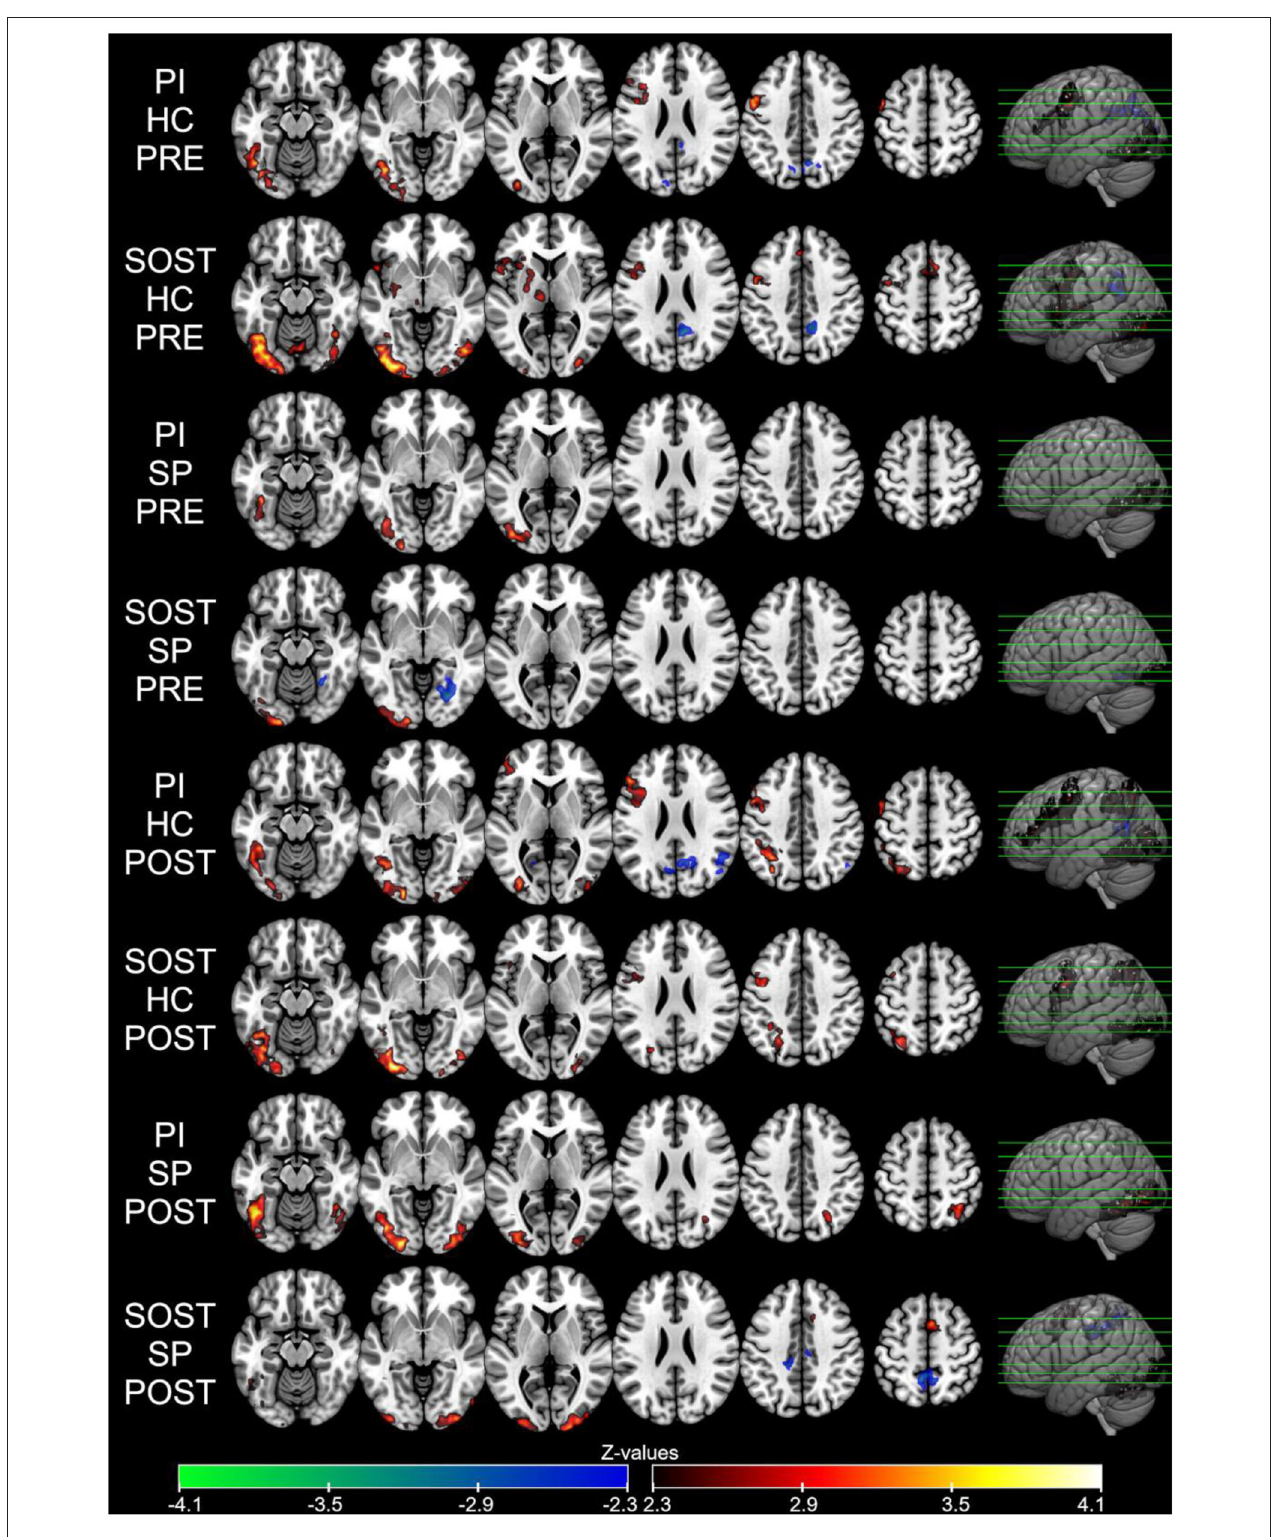
FIGURE 5 | Average BOLD responses in SR task block for each group in each run (Pre and Post-intervention) presented as Z- values (neurological orientation). Voxel threshold of Z > 2.3 and cluster corrected threshold of p < 0.05. PI, Psychoeducation Intervention; SOST, Semantic Organization Strategy Training; HC, Healthy Controls; SP, Stroke